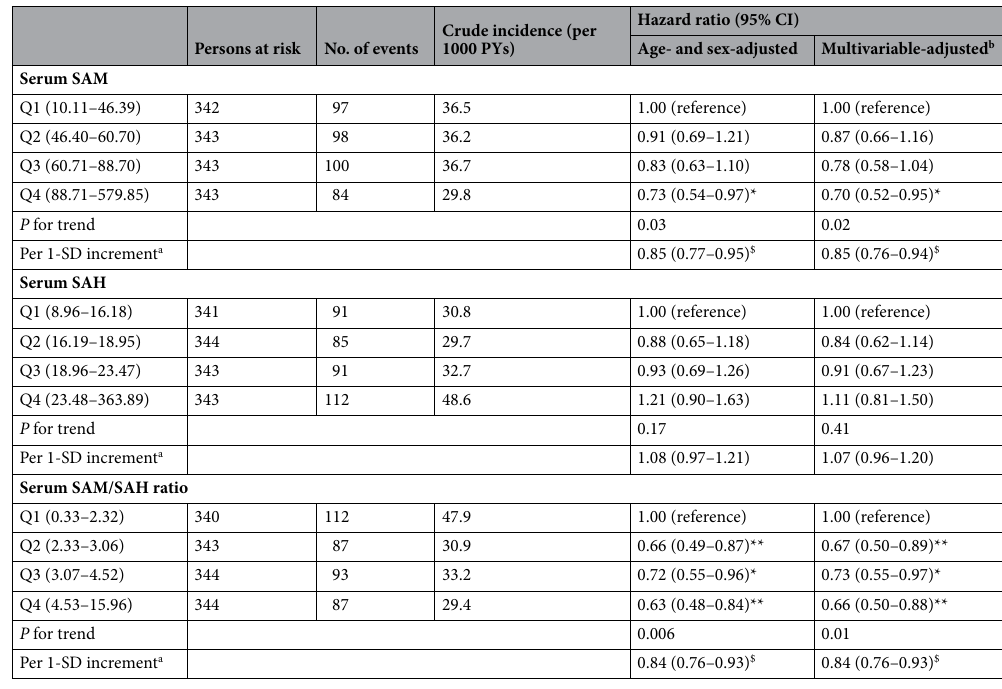
Table 3. The risk of all-cause dementia according to serum SAM, SAH and SAM/SAH ratio levels (2007– 2017). CI confidence interval, PYs person-years, SAH s-adenosylhomocysteine, SAM s-adenosylmethionine, SD standard deviation. a 1-SDs of natural log-transformed values of serum SAM, serum SAH, and the serum SAM/SAH ratio were 0.46, 0.32, and 0.54. b Adjusted for age, sex, education, hypertension, diabetes mellitus, serum total cholesterol, body mass index, history of stroke, current smoking, current drinking, regular exercise and use of vitamin B supplements. * P < 0.05, ** P < 0.01 versus Q1. $ P < 0.05 per 1-SD